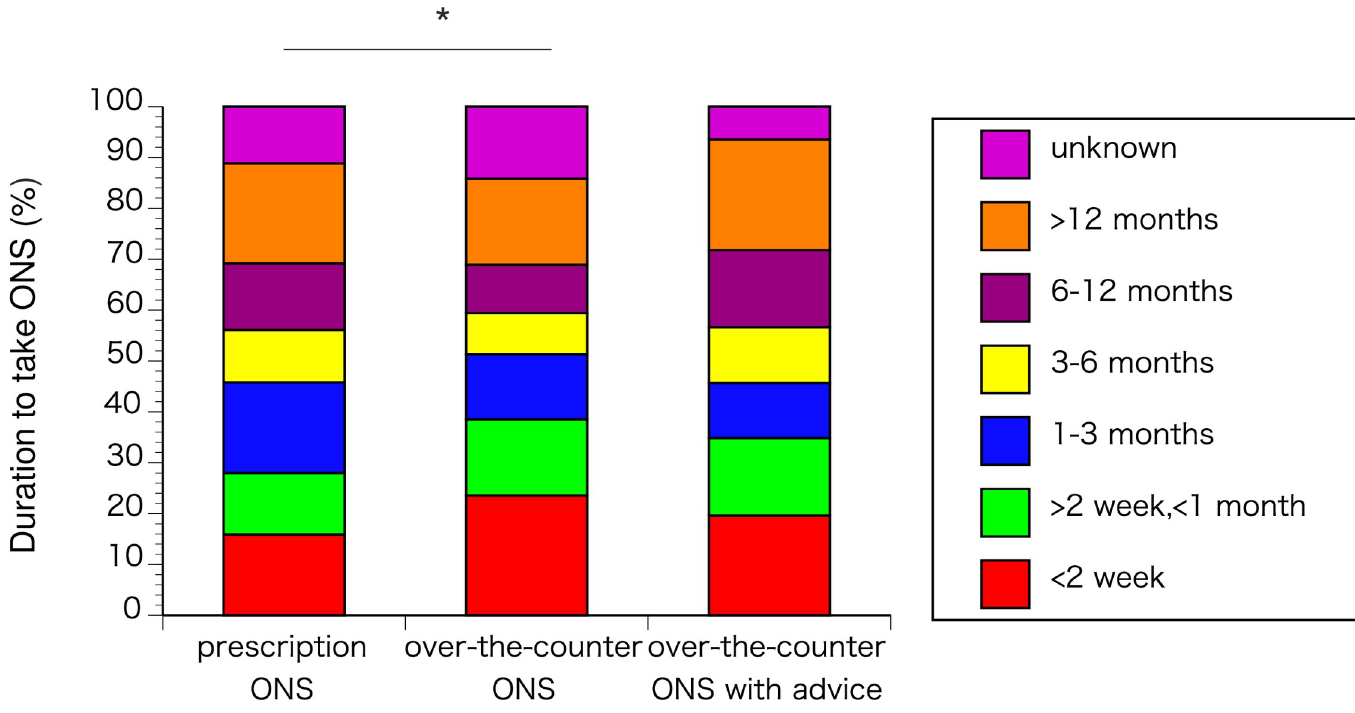
Fig 4. Duration taking ONS. � p <